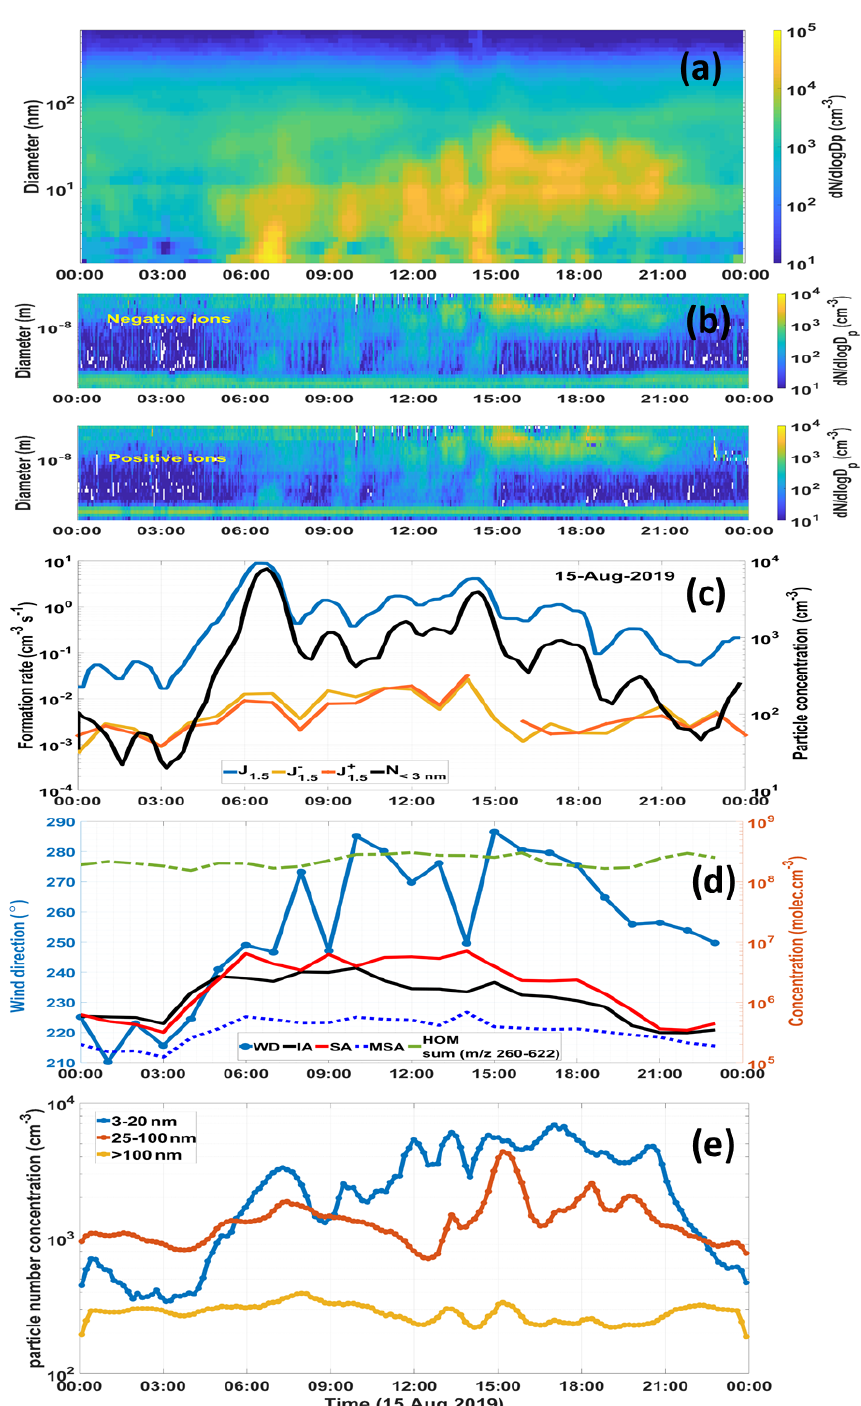
Figure 10. Multiple bursts/spikes on 15 August 2019. (a) Number size distribution of particles (data from the PSM, the NAIS and the DMPS; size range: 1–100nm). (b) Charged-particle number size distribution (negative: upper, positive: lower) obtained from the NAIS. (c) Diurnal variation in formation rates ( J 1 . 5 ) of 1.5nm particles and ions ( J − and J + ) and total number concentrations of particles ( < 3nm, 1 . 5 1 . 5 PSM). (d) Diurnal variation in HOMs SA, IA and MSA with wind direction (WD). (e) The diurnal variation in particle concentration in nucleation (3–20nm), Aitken (25–100nm) and accumulation mode ( > 100nm) particles (DMPS